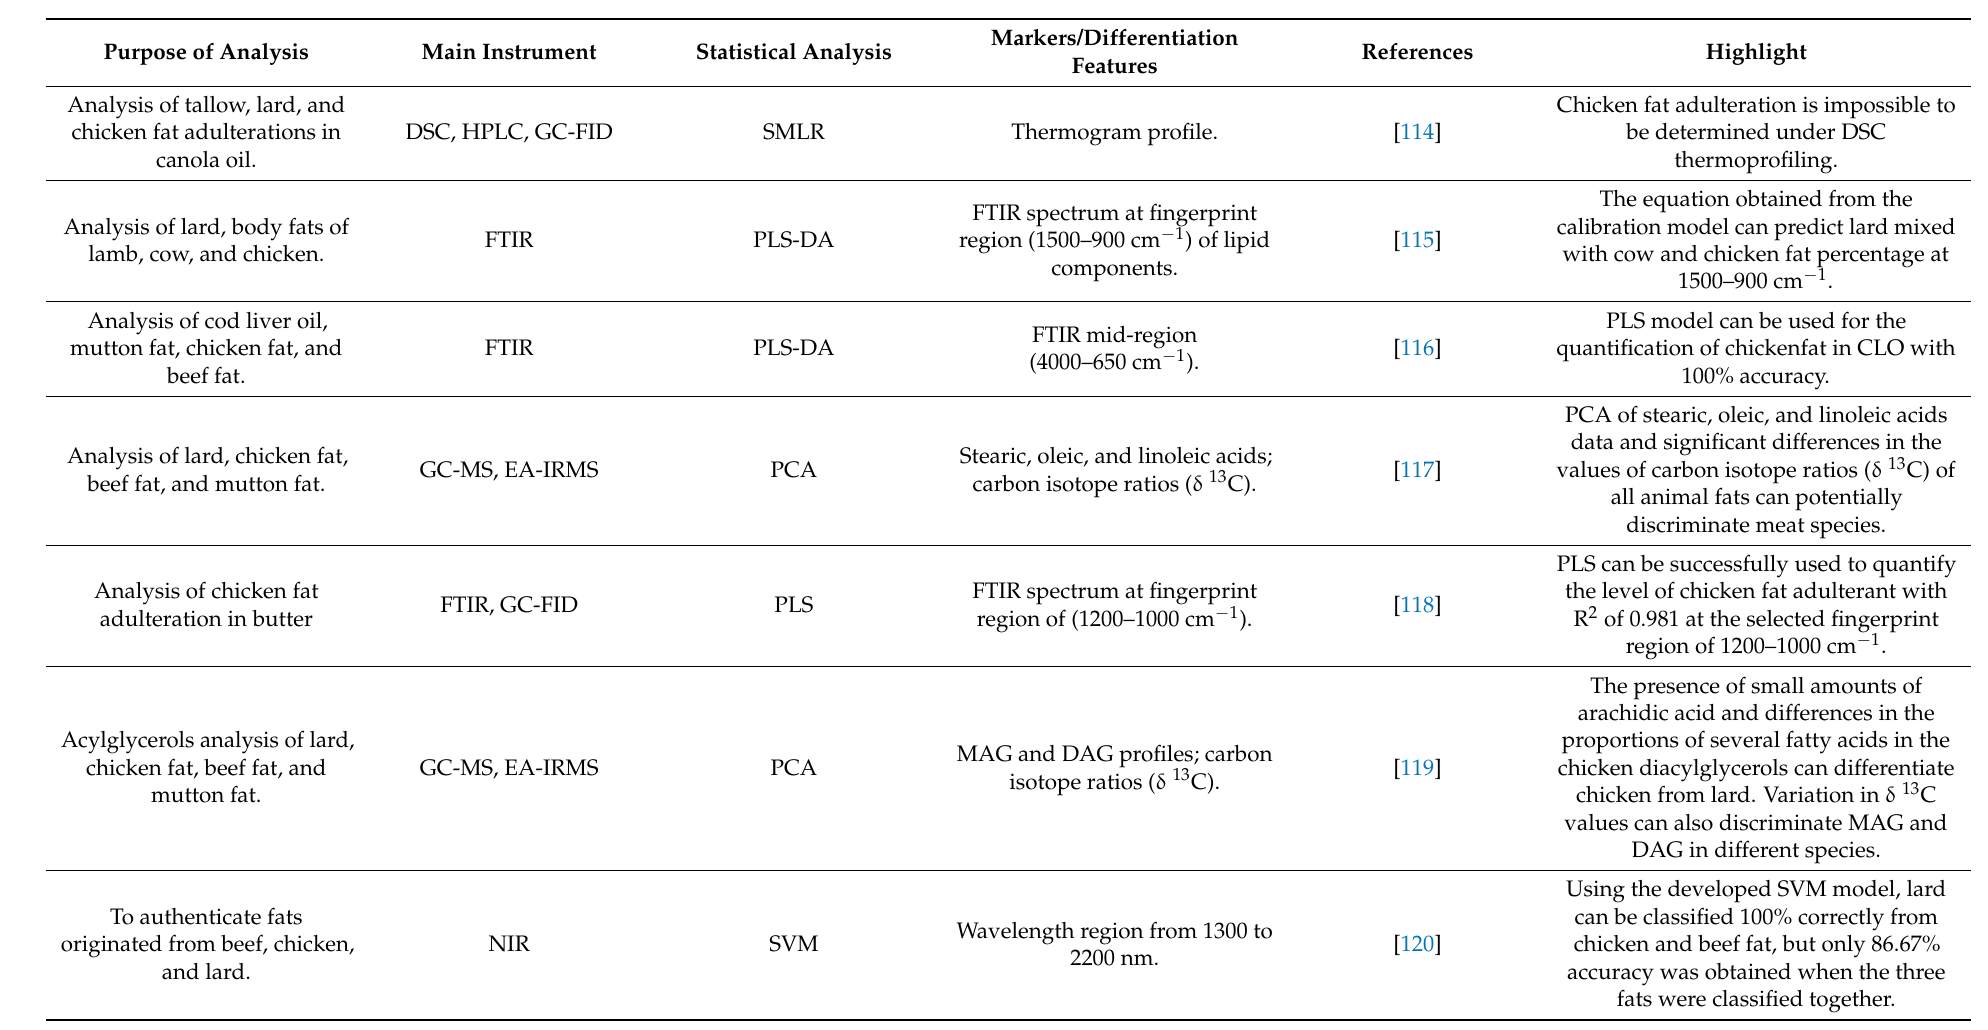
Table 4. Summary of lipidomic application in chicken authentication. Type of samples and performance (limit of detection and discriminating accuracy) are included when